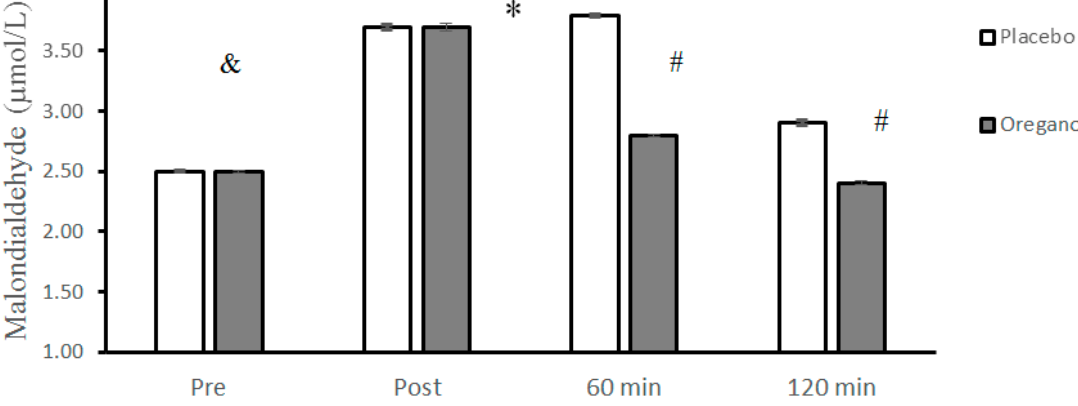
Figure 4. Mean ± standard deviations (SD) of plasma MDA levels before and at different times after consuming oregano supplements. The asterisk (*) indicates significant time × group interaction, (#) indicates a significant difference between the two groups, and (&) indicates the main effect of time ( p < 0.05).